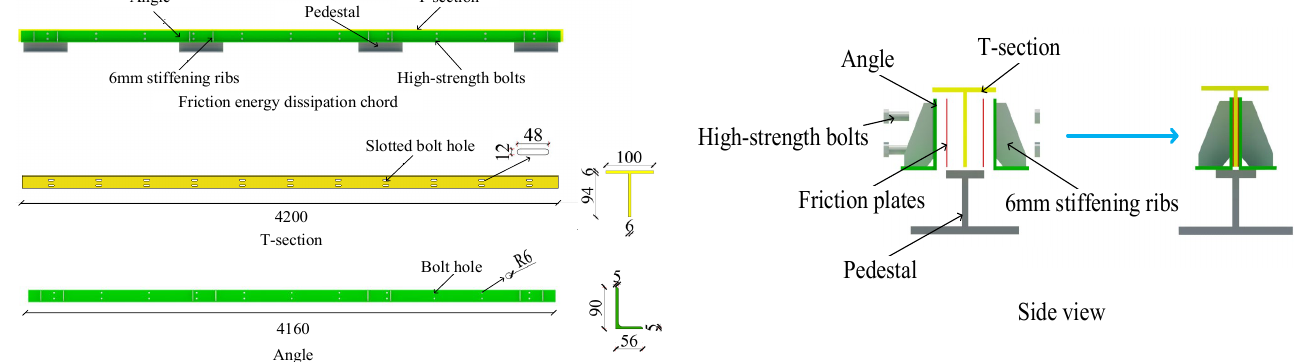
Figure 3. The structure diagram of the friction energy dissipation composite chord specimen (based on SJ1).